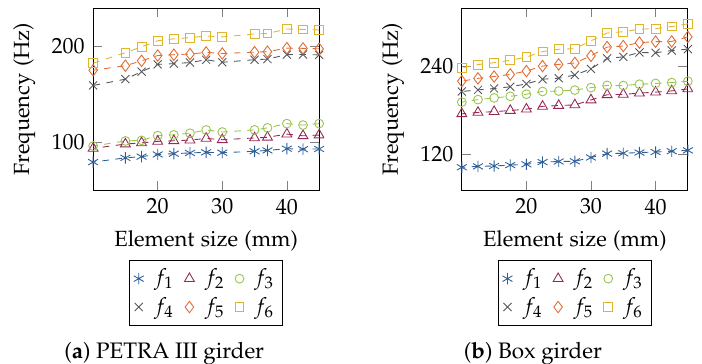
Figure 13. First six eigenfrequencies depending on the element size for the PETRA III girder ( a ) and the box girder ( b ). An element size of 20 mm was chosen.